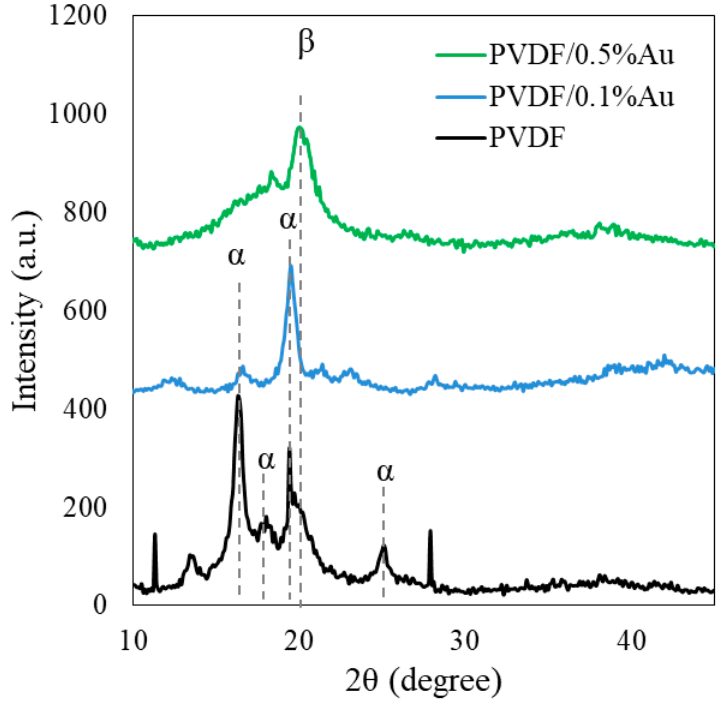
/ Au Figure 7. XRD pattern of PVDF and PVDF/Au nanocomposites. Figure 7. XRD pattern of PVDF and PVDF Figure 7. XRD pattern of PVDF and PVDF/Au nanocomposites.